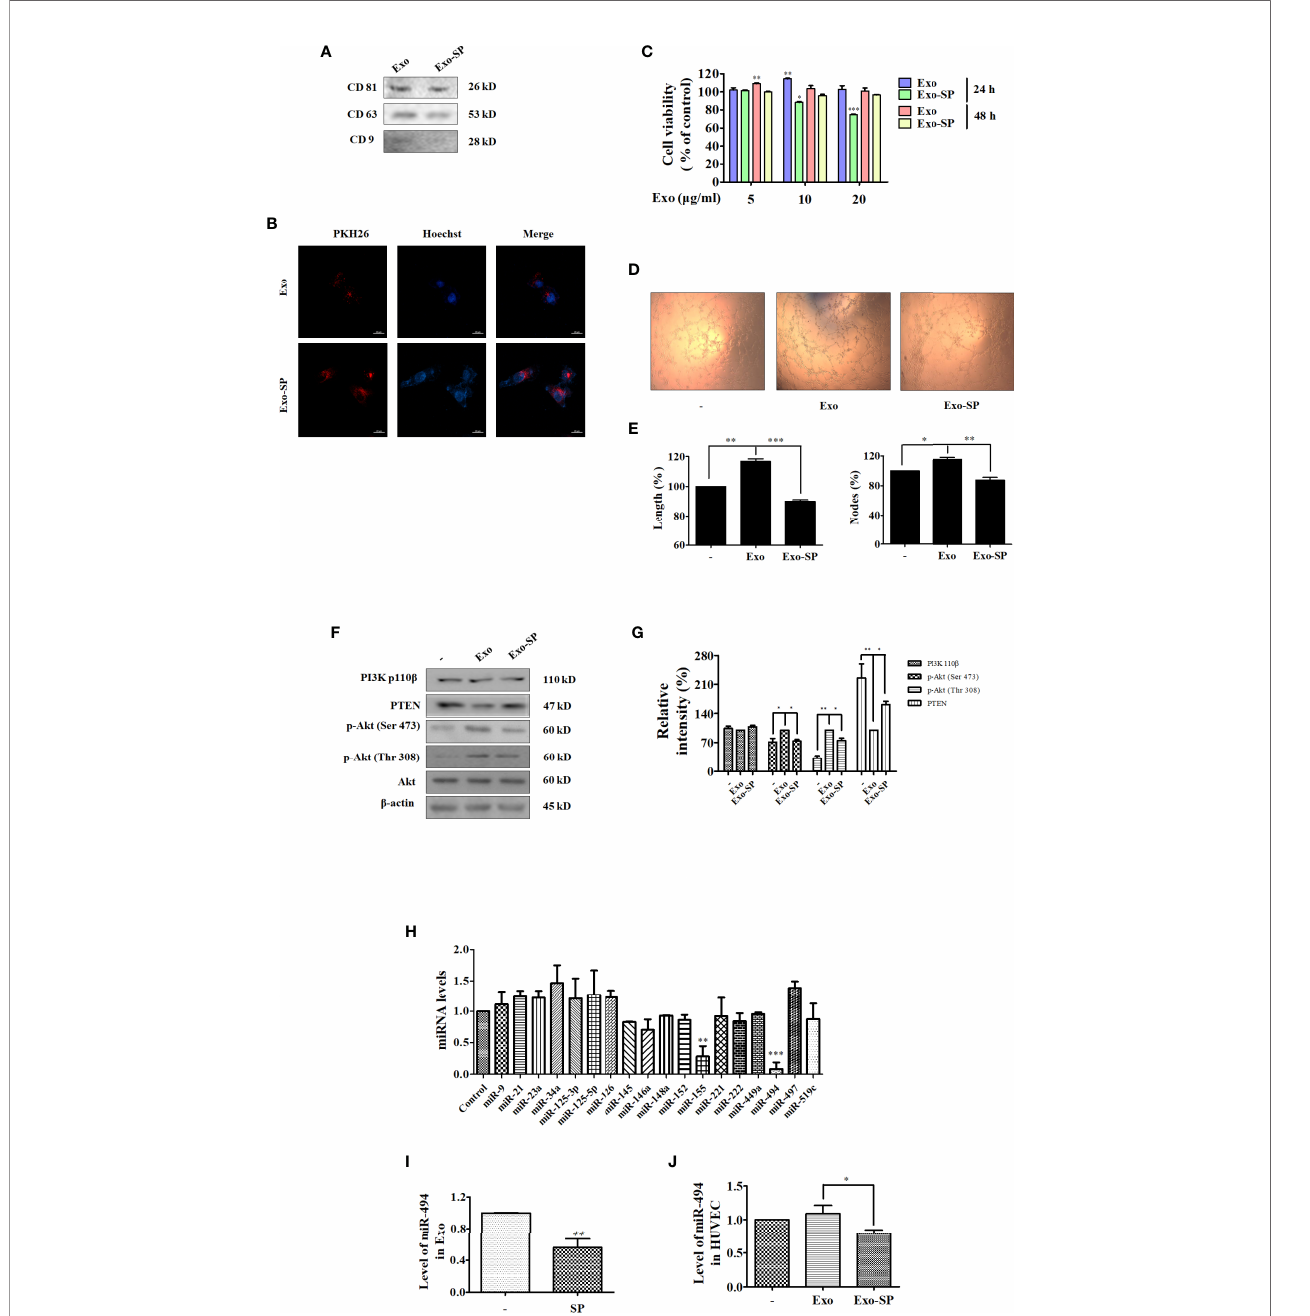
FIGURE 2 | Exo-SP inhibits tube formation and suppresses PTEN/Akt pathway in the recipient HUVECs, and the levels of miRNAs in A549 or SP600125 treated A549 cells, Exo or Exo-SP, and HUVECs treated with Exo or Exo-SP (A) A549 cells were treated with or without 50 m M of SP600125 for 48 h in FBS free RPMI 1640 medium, and Exo and Exo-SP were isolated. Expression of exosomes markers CD81, CD63 and CD9 in the Exo and Exo-SP was detected by Western blot. (B) The isolated Exo and Exo-SP were labeled with PKH26 and Hoechst, and incubated with HUVECs for 3 h. The cellular uptake of Exo or Exo-SP was observed under fl uorescent microscope. (C) HUVECs were treated with different concentrations (5, 10, 20 m g/ml) of Exo or Exo-SP for 24 h or 48 h, respectively. Cell viability was determined by MTT assay. (D) HUVECs were treated with Exo or Exo-SP for 24 h, and then seeded on Matrigel. Formation of tube-like structures was examined 3 h later. (E) Quantitative data for the tube-like structures were obtained by analyzing Length (%) and Nodes (%) density with Image J software. (F) HUVECs were treated with Exo or Exo-SP for 24 h, and then collected and lysed for immunoblot with speci fi c antibodies. (G) Quanti fi cation of the results in (F) . (H) The levels of various miRNAs in A549 cells treated with or without SP600125 for 48 h. (I) The level of miR-494 in Exo and Exo-SP. Exosomes isolated from A549 cells were treated with or without SP600125 for 48 h, to be available for miR-494 analysis. (J) The level of miR-494 in HUVECs treated with Exo or Exo-SP for 24 h. Data show the mean ± SD of three independent experiments. *p < 0.05, **p < 0.01, and ***p <